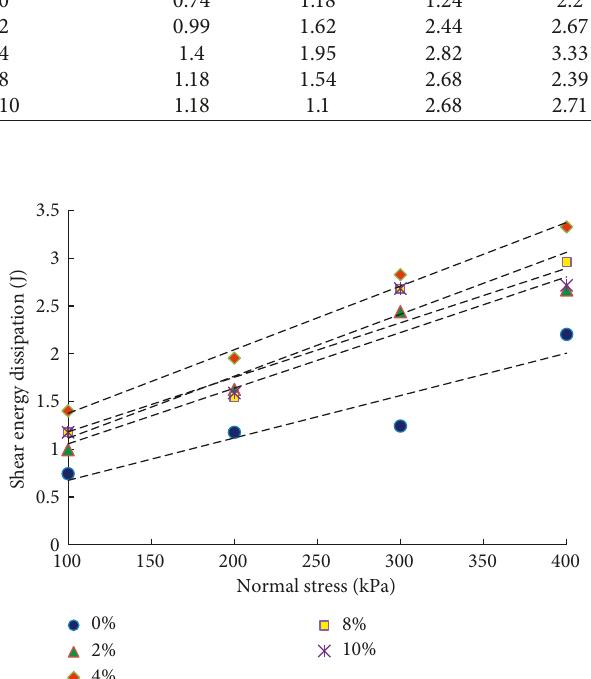
Figure 8: Shear energy dissipation of lime-reinforced iron tailing powder under different normal stresses.